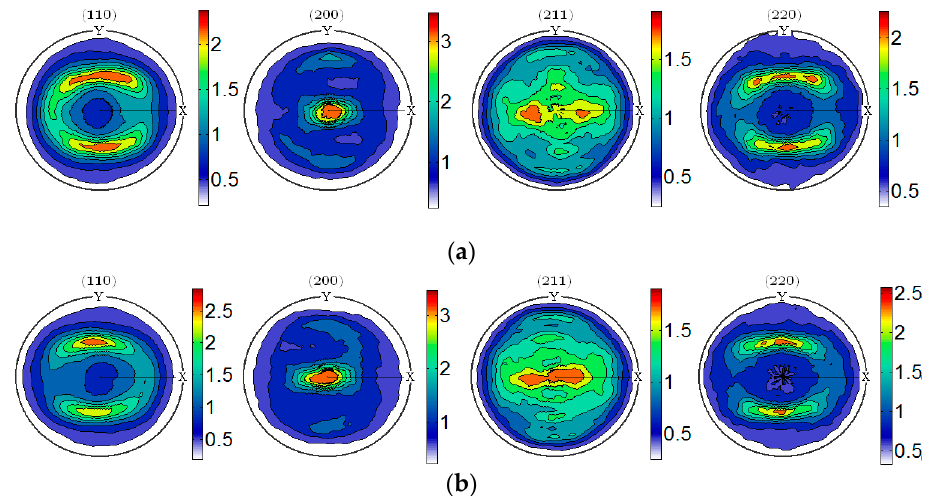
Figure 5. The pole figures of DP800, ( a ) before and ( b ) after deformation with ε = 0.125.